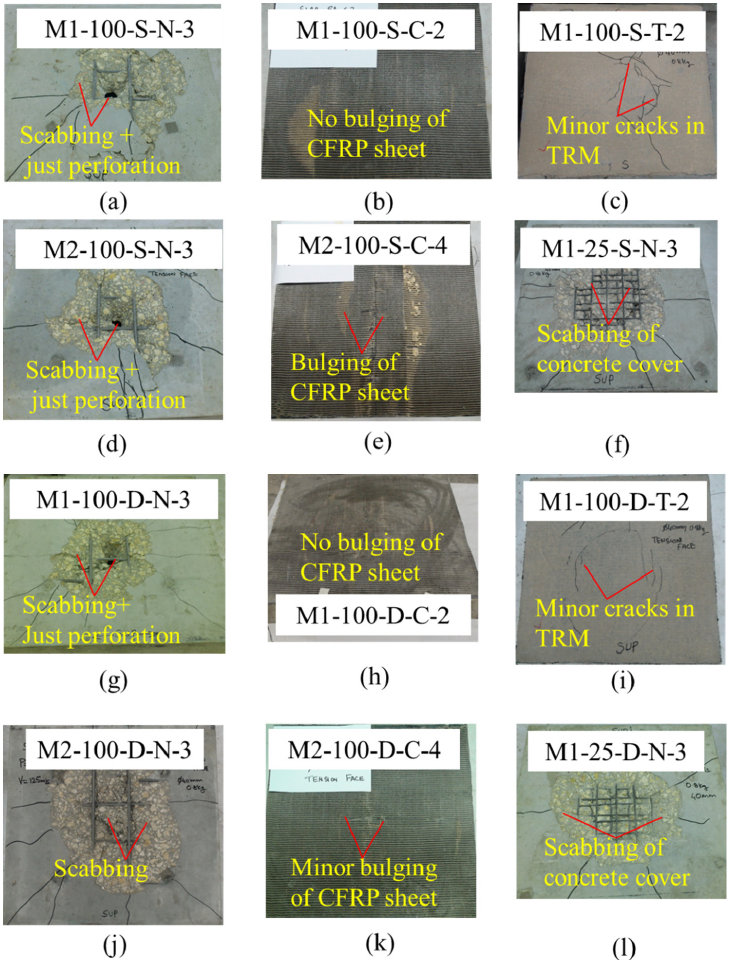
Figure 9. Back face damage caused by projectile strike at ~125 m/s in slabs: ( a ) M1-100-S-N-3; ( b ) M1-100-S-C-2; ( c ) M1-100-S-T-2; ( d ) M2-100-S-N-3; ( e ) M2-100-S-C-4; ( f ) M1-25-S-N-3; ( g ) M1-100-D- N-3; ( h ) M1-100-D-C-2; ( i ) M1-100-D-T-2; ( j ) M2-100-D-N-3; ( k ) M2-100-D-C-4; ( l )